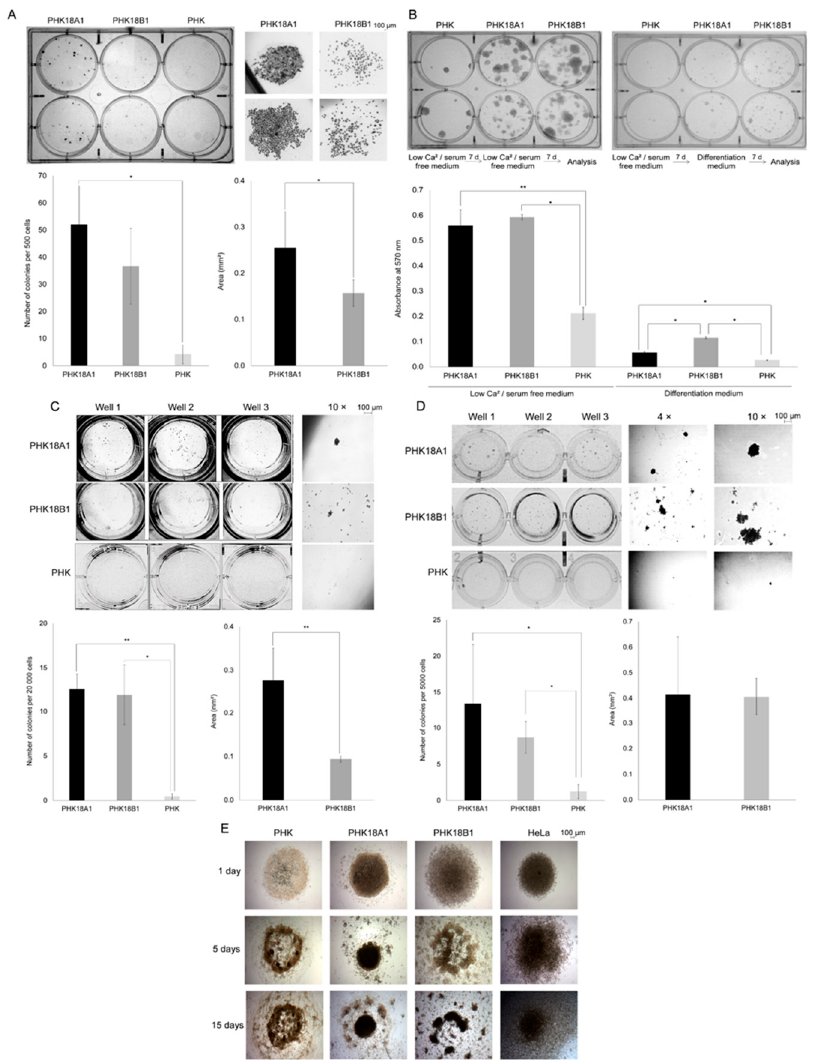
Figure 4. Colony and spheroid formation by immortalized PHK18A1 and PHK18B1 in monolayer and 3D cultures: ( A ) colony formation efficiency after low-density plating. Seven days following plating, cells were fixed and stained with crystal violet. Representative plates from three independent experiments are shown, in addition to an example of colonies formed in 4× magnification. Histograms show the average number and area of colonies formed. * p = 0.00; ( B ) efficiency of colonies formation resistant to differentiation induced by serum and calcium. Seven days following plating, culture medium was either maintained (control) or replaced for a differentiation-inducing medium. After one week, colonies were stained with MTT. Cells were then diluted in DMSO and absorbance measured at 570 nm. Images illustrate a representative out of three independent experiments. * p = 0.00, ** p = 0.01; ( C ) efficiency of spheroid formation in low-attachment plates. Fourteen days following plating, cells were imaged. Representative wells obtained from three independent experiments conducted in triplicate, in addition to 10 × magnification images are shown Histograms show the average number and area of spheroids formed. * p = 0.00, ** p = 0.01; ( D ) efficiency of colony formation in semisolid medium. Cells were grown in 0.5% soft agar in triplicates. After 15 days, cells were stained with MTT. Images illustrate representative wells from three independent experiments, in addition to images of the colonies under 4 × and 10 × magnification. Histograms show the average number and area of colonies formed. * p = 0.00; ( E ) efficiency of spheroid formation through magnetic bioprinting of cells. Cells were incubated with Nanoshuttle-PL solution and further seeded in low-attachment plates on top of a magnetitic spheroid driver for 24 h. Spheroid’s growth was monitored for 15 days. Solely one experiment was conducted with an average of 20 replicates for each cell line evaluated. The T -test was used in the statistical analysis.